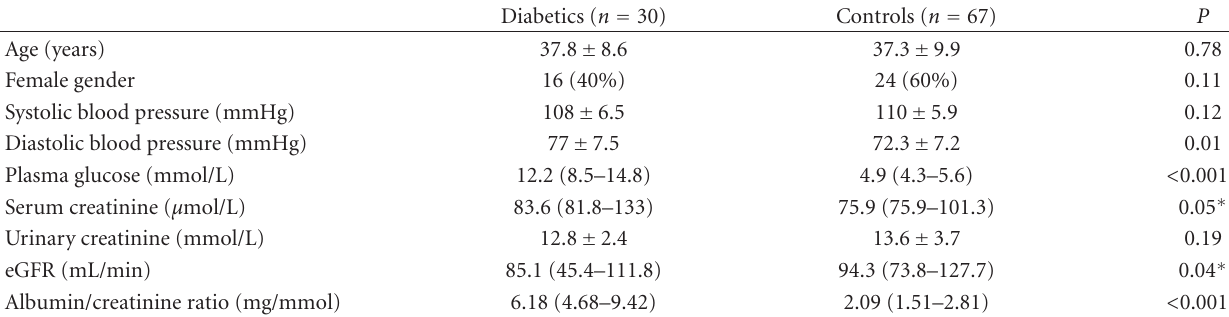
Table 1: Sociodemographic and clinical